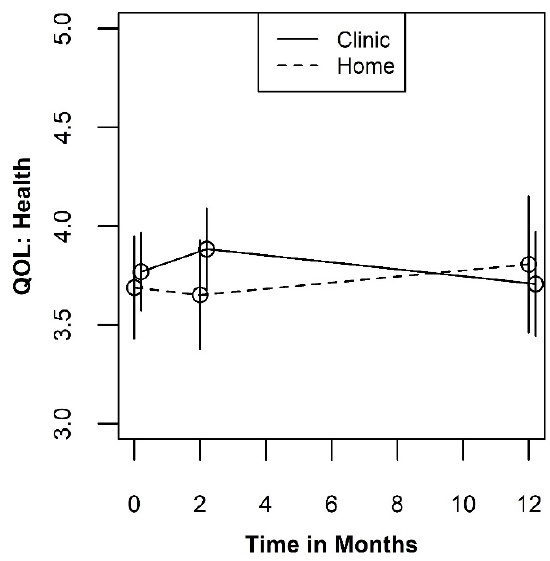
Figure 3. Plots of QOL Health by HIV test result.